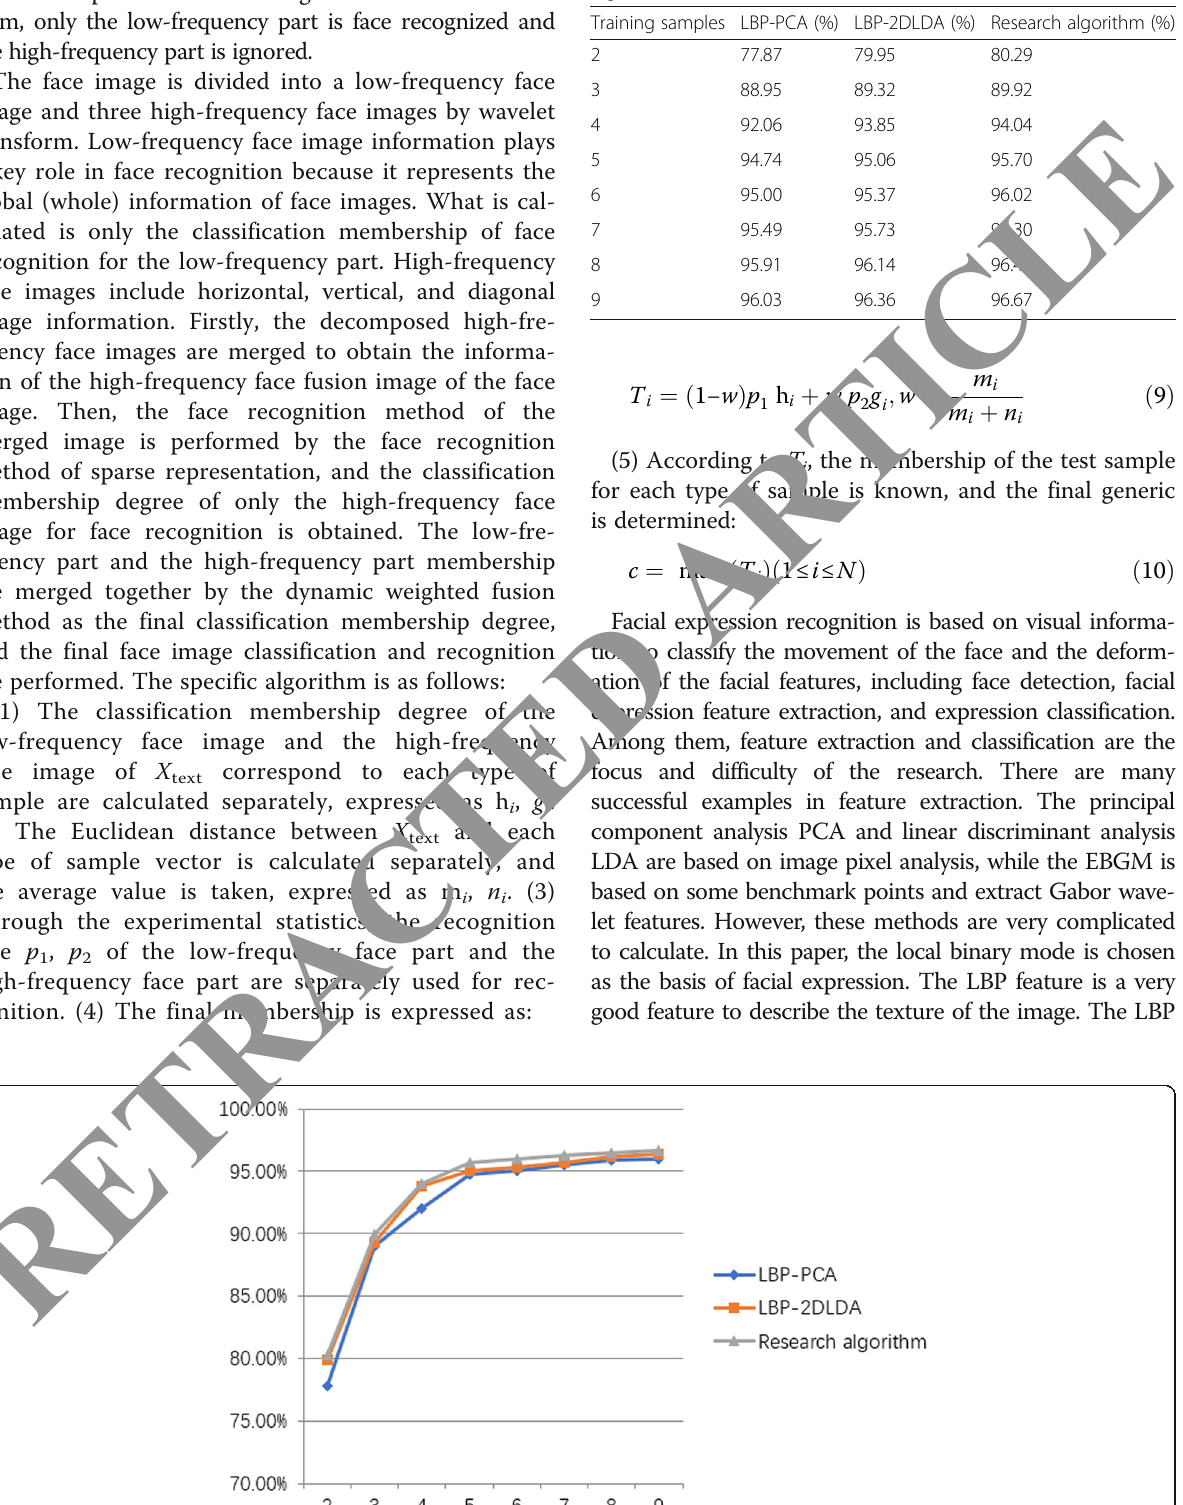
Table 1 Comparison of face recognition rates of different algorithms